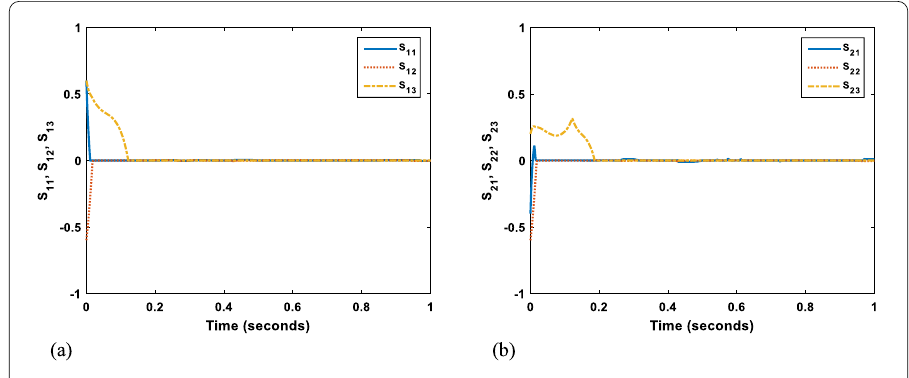
Figure 10 State trajectories of the sliding surface: ( a ) S 11 ( t ), S 12 ( t ), S 13 ( t ) and ( b ) S 21 ( t ), S 22 ( t ), S 23 ( t